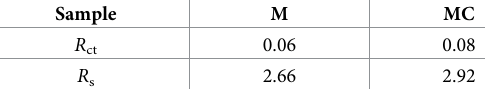
Table 2. Data collected from EIS curves.